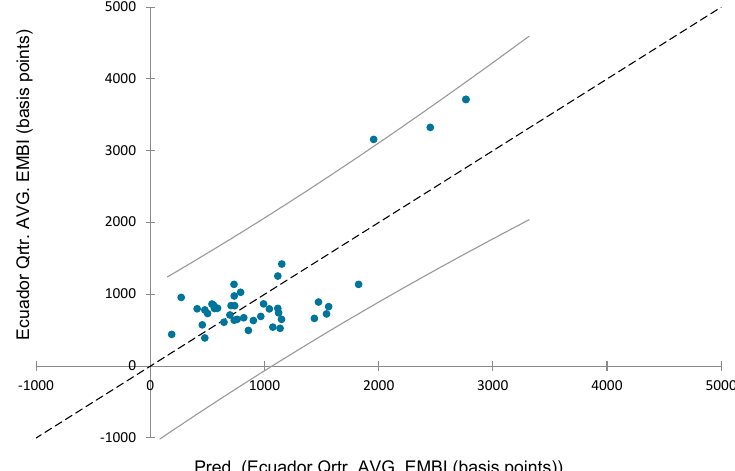
Figure 3. Ecuador predicted vs. actual EMBI spread.